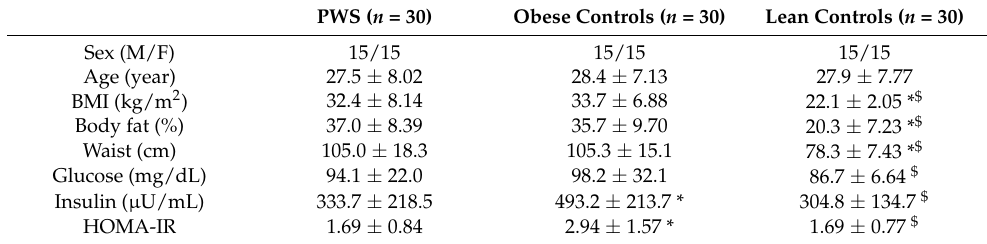
Table 1. Baseline characteristics of all groups.